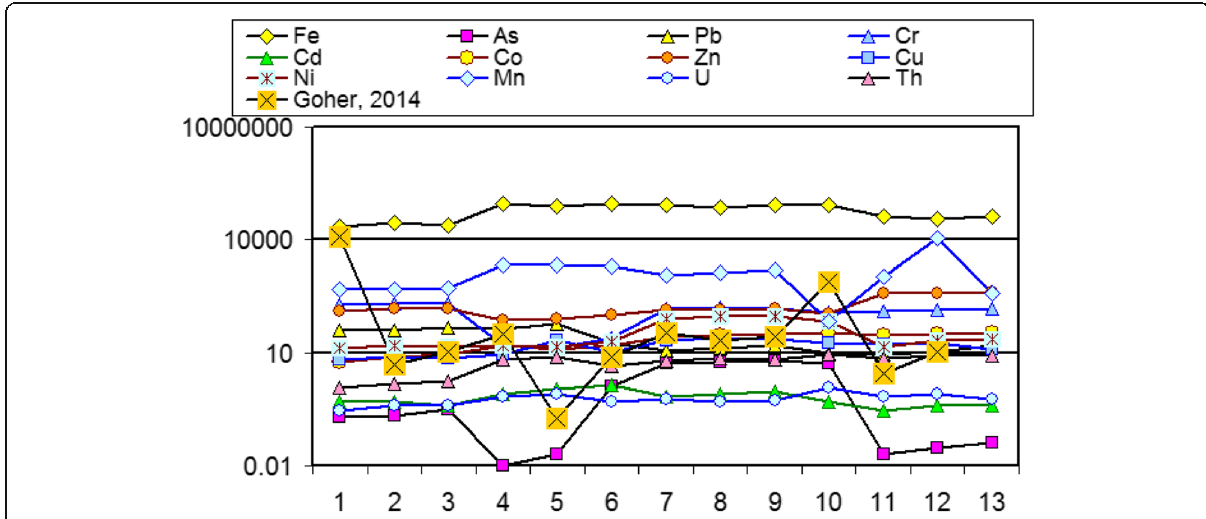
Fig. 2 Concentration of the heavy metals (ppm) of the studied samples